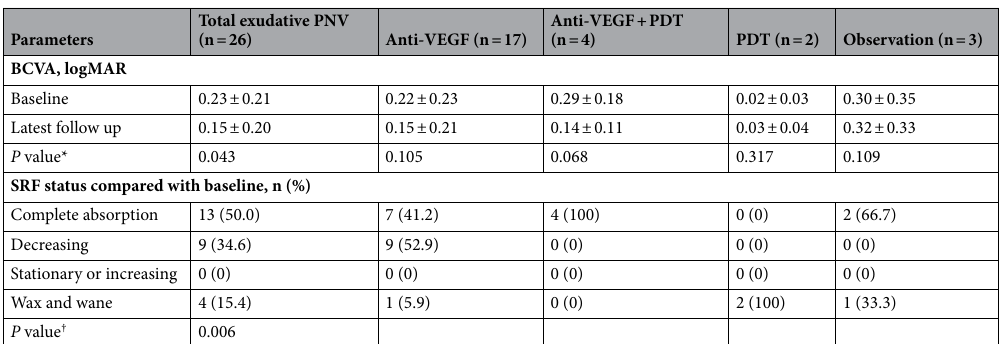
Table 3. Longitudinal changes in the exudative PNV group according to the treatment patterns. PNV, pachychoroid neovasculopathy; VEGF, vascular endothelial growth factor; PDT = photodynamic therapy; BCVA = best-corrected visual acuity; logMAR = logarithm of the minimum angle of resolution; SRF = subretinal fluid. Continuous variables are reported as mean value (± SD). *Wilcoxon signed-rank test; † Fisher’s exact